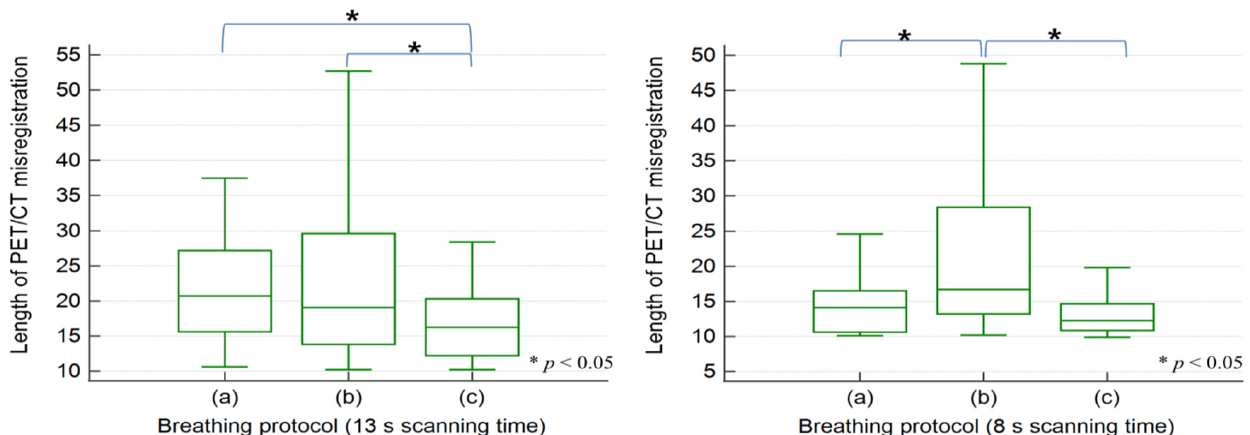
Figure 3. Statistical analysis of the lengths of PET/CT misregistrations for various breathing protocols and CT scanning times.